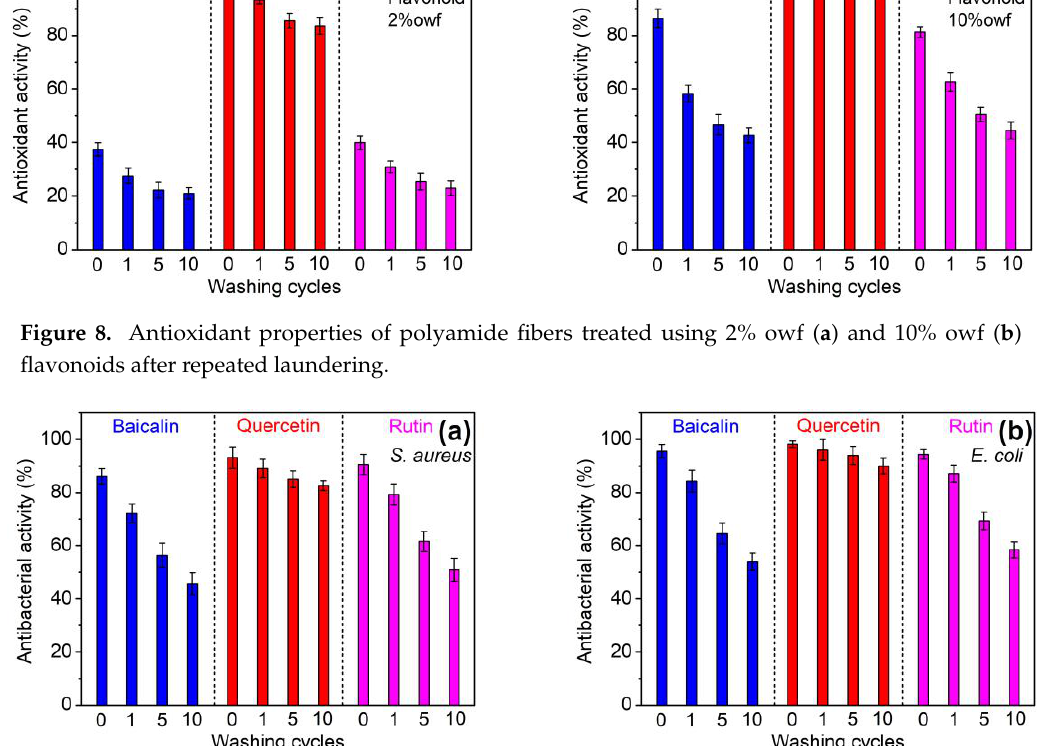
Figure 9. Antibacterial properties against S. aureus ( a ) and E. coli ( b ) of polyamide fibers treated using 10% owf flavonoids after repeated laundering.